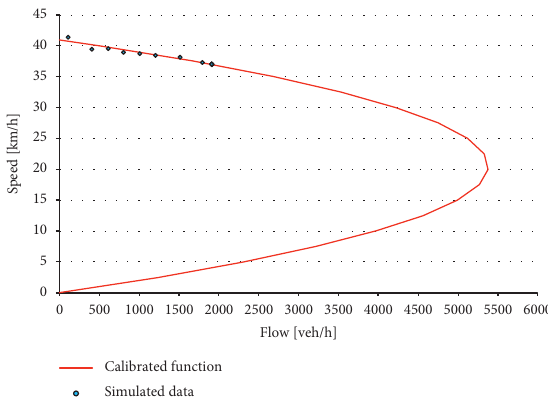
Figure 8: Calibrated function f � f ( v ) in the case of network configuration 2 for the interfaceable